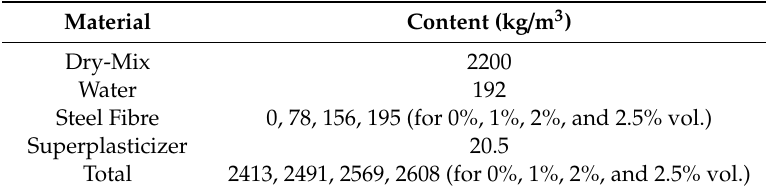
Figure 1. Straight steel fibres used in research. Table 1. Mix proportion for pre-mix ultra-high performance fibre reinforced concrete (UHPFRC; provided by third party company).